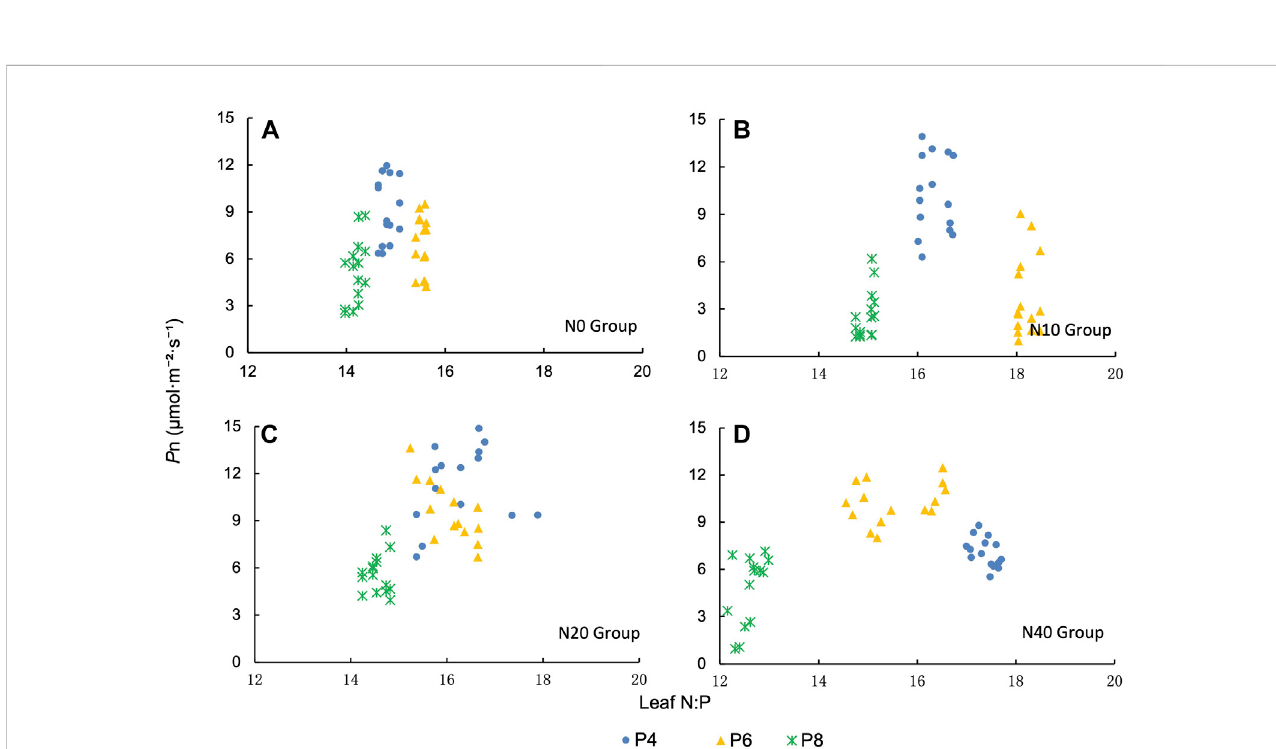
FIGURE 7 Relationship between N/Pratio andnetphotosyntheticrate( Pn )in P.tanacetifolia leaves. (A) N0group, (B) N10 group, (C) N20groupand (D) N40group.